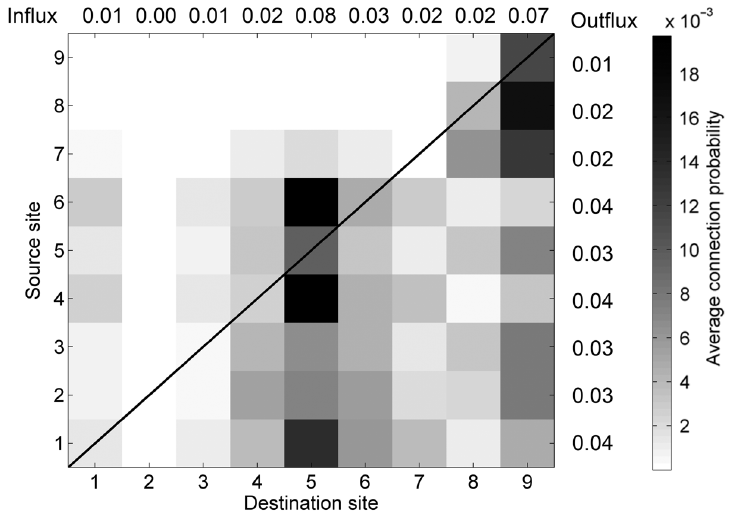
Fig. 2. Average connectivity matrix for 9 sites in Loch Fyne, from twelve 2 wk simulations using wind-forcing data from throughout the year. Darker colour indicates higher connection probability (probability of successful dispersal from one site to another). Connections indicate predominantly northeasterly transport within the loch, due to prevailing southwest wind forcing of surface layers. Column and row sums are the